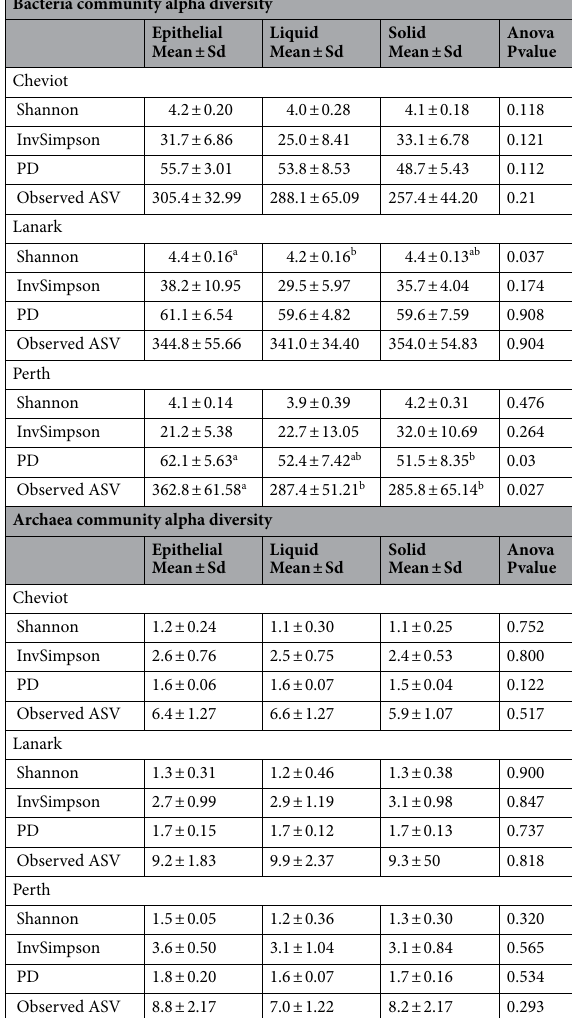
Table 6. Alpha diversity analysis. Measures of alpha diversity (Shannon, Inverse Simpson, Phylogenetic diversity and Observed ASV) for bacterial and archaeal communities, reported as Mean ± Sd. Effect of breed on alpha diversity tested using 2 way ANOVA. Cheviot (solid n = 7, liquid n = 7, epithelial n = 7), Lanark (solid n = 5, liquid n = 5, epithelial n = 5), Perth (solid n = 5, liquid n = 5, epithelial n = 5).